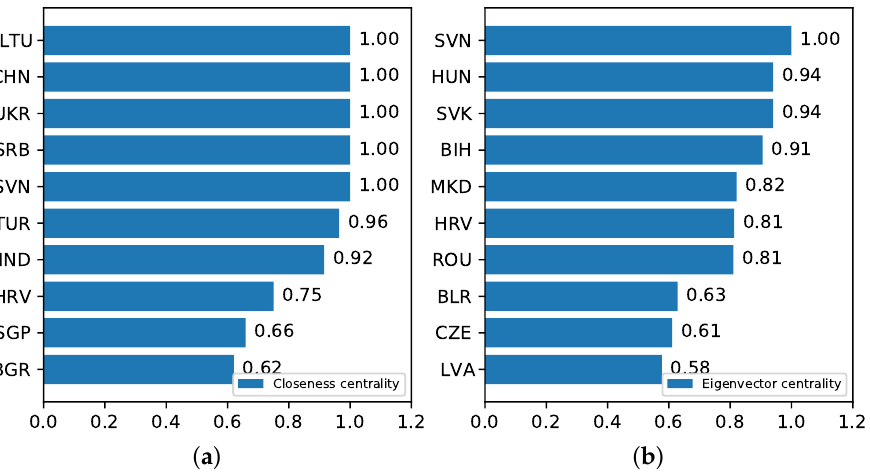
Figure 5. Top 10 countries in the EGSR transmission network in terms of ( a ) closeness centrality and ( b ) eigenvector centrality.